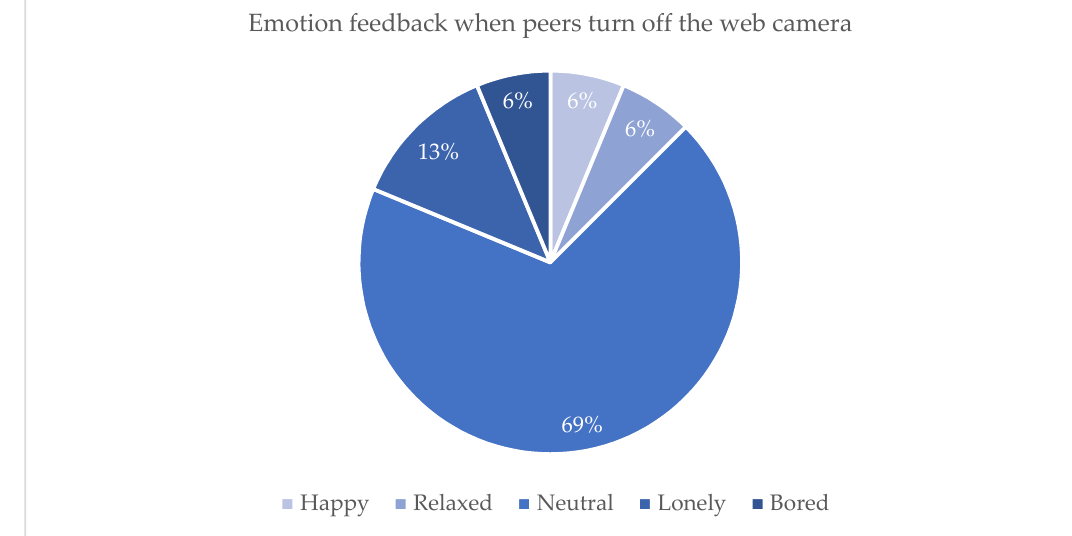
Figure 7. The breakdown of emotional feedback when peers disabled their web cameras during a virtual conference meeting.